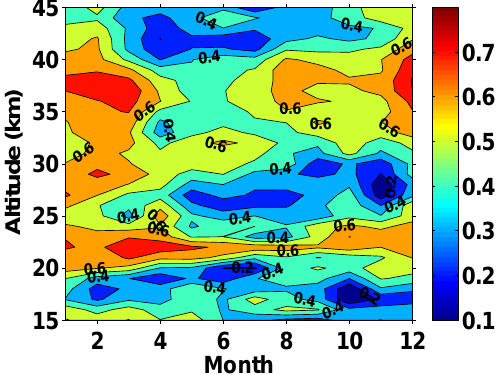
Fig. 5. Seasonal variations of the vertical distribution of R 2 esti- mates computed for the average of the stratospheric ozone anoma- lies at OHP from different observations.